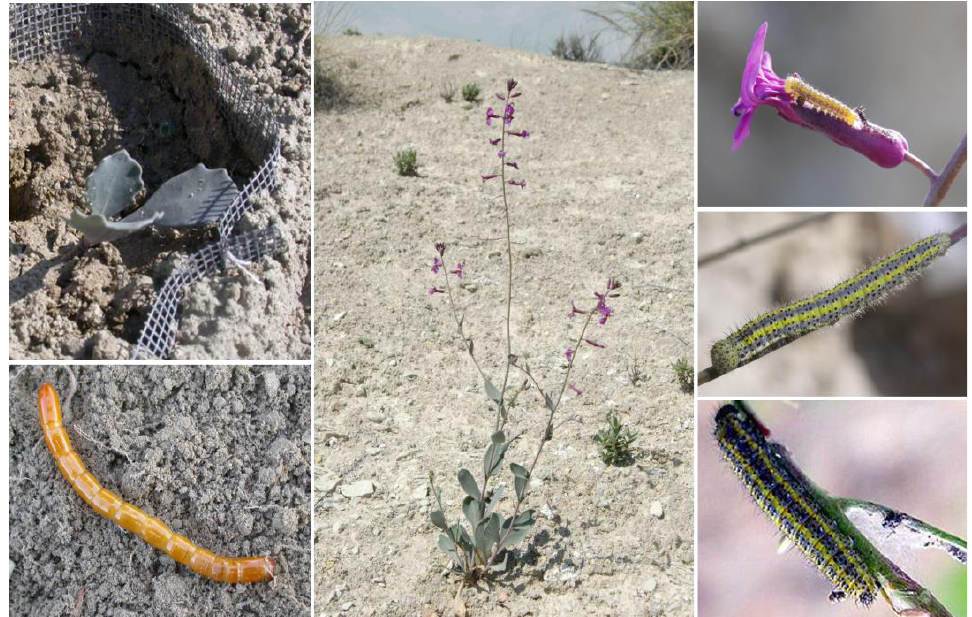
Figure 6. Top left, example of Moricandia moricandioides plant when moved to the field and re-potted in fiber-glass-mesh cylinders. Bottom left, late larval instar of Cebrio gypsicola . Middle, natural M. moricandioides individual in the study area. Top right, early larval instar of Euchloe crameri feeding on a M. moricandioides flower. Middle right, late larval instar of E. crameri . Bottom right, late larval instar of Pontia daplidice (author: José Manuel Benito Á lvarez, Creative Commons BY-SA 2.5 ES).